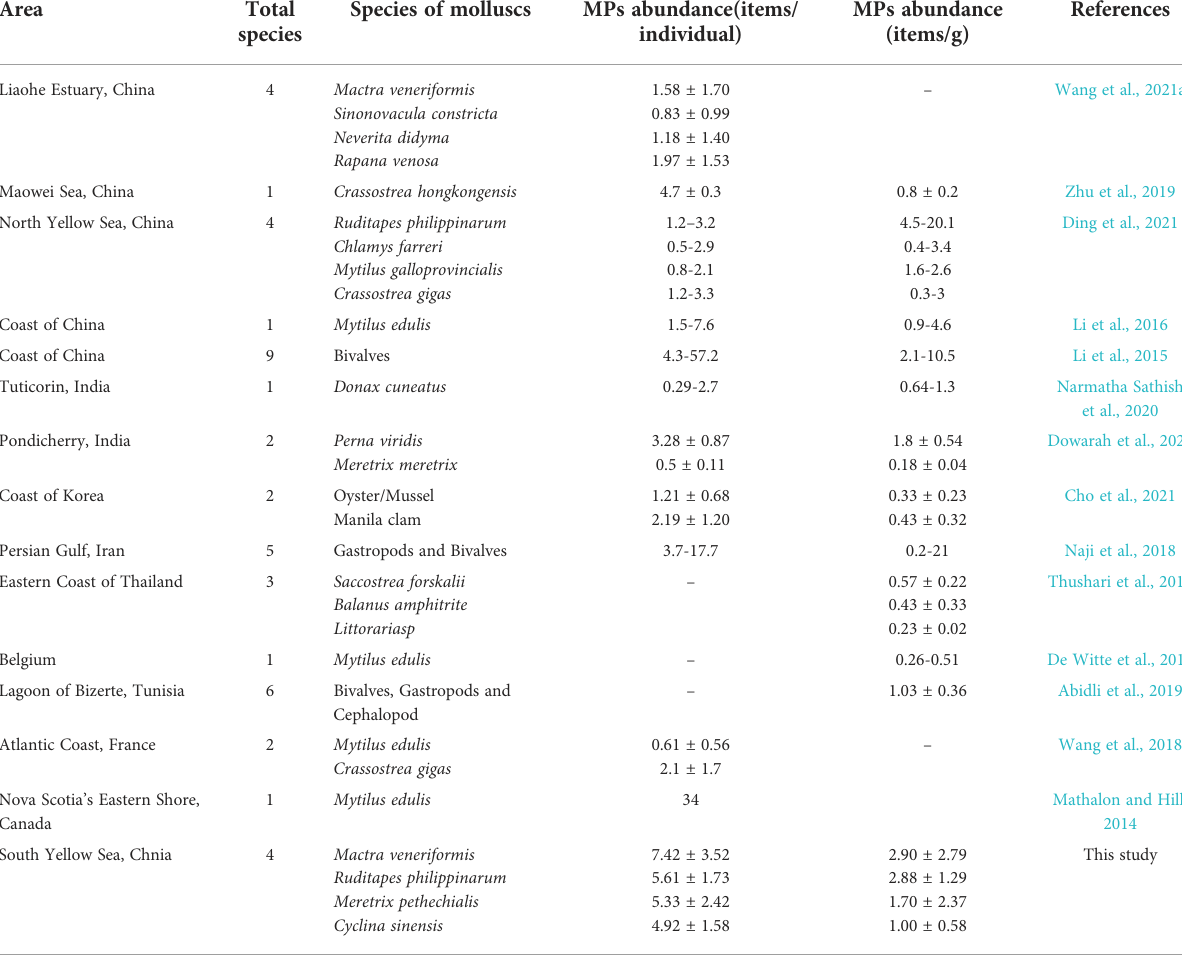
TABLE 2 A summary of MPs abundances (mean values) found in main molluscs in this and previous studies.